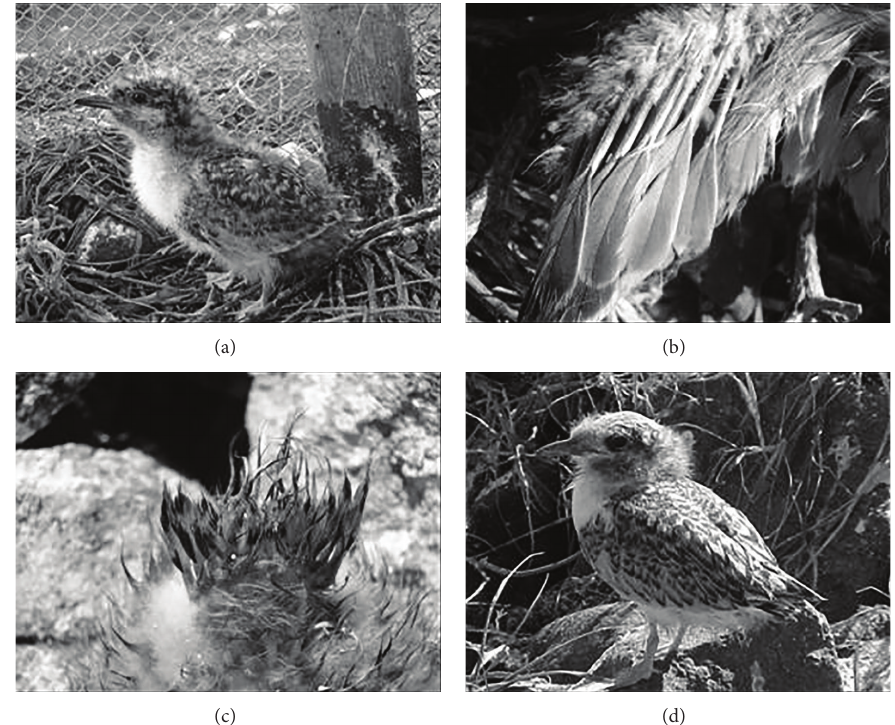
Figure 5: JIII of Sterna hirundinacea in the beginning of this phase (a), details of the cannon feathers on the remiges (b), rectrices (c), and end of the stage (d).